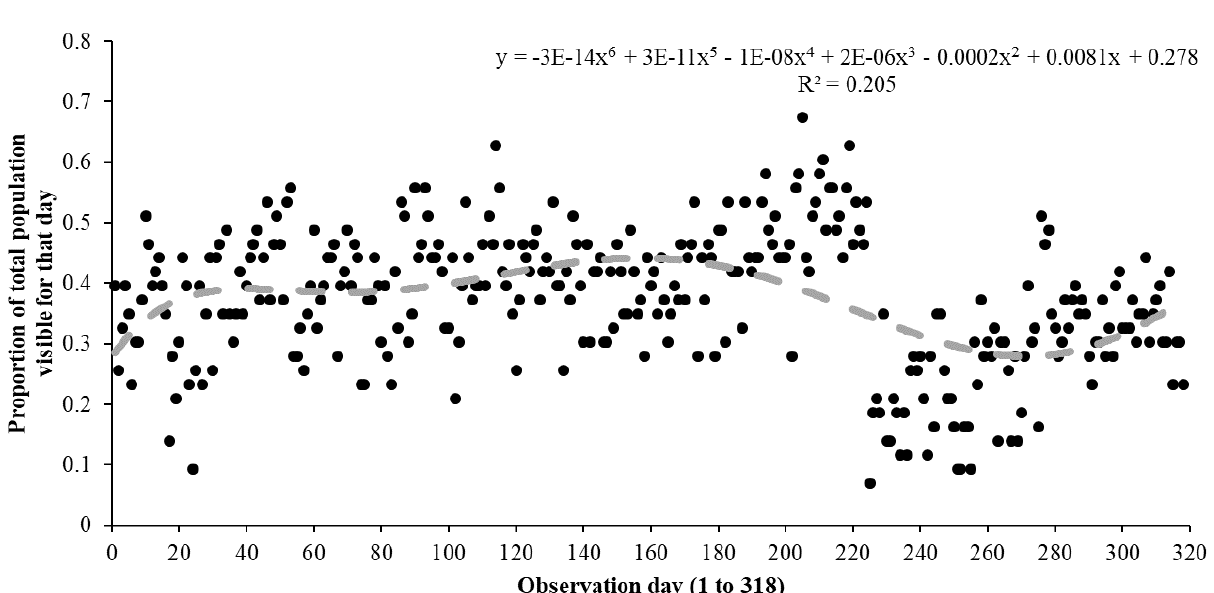
Figure 2. Scatterplot with best fit polynomial trend line showing that amphibian visibility increased during lockdown (day 1 to 165) and then dropped when people returned to the centre (day 166 onwards), but visibility increased again at the end of the study, suggesting the visitor effect may be temporary.